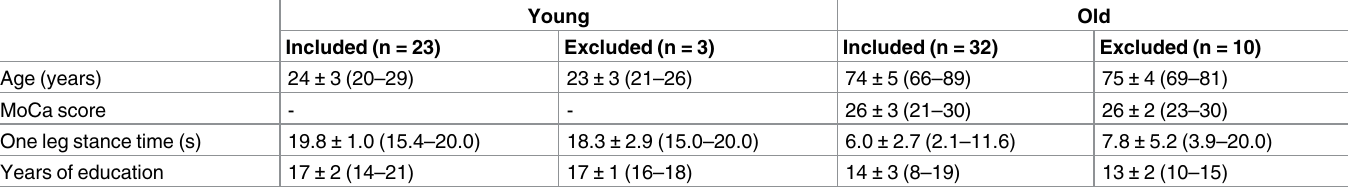
Table 1. Subject characteristics. Values are mean ± SD, with the range between brackets. MoCa: montrealcognitive asessment (max. score of 30).